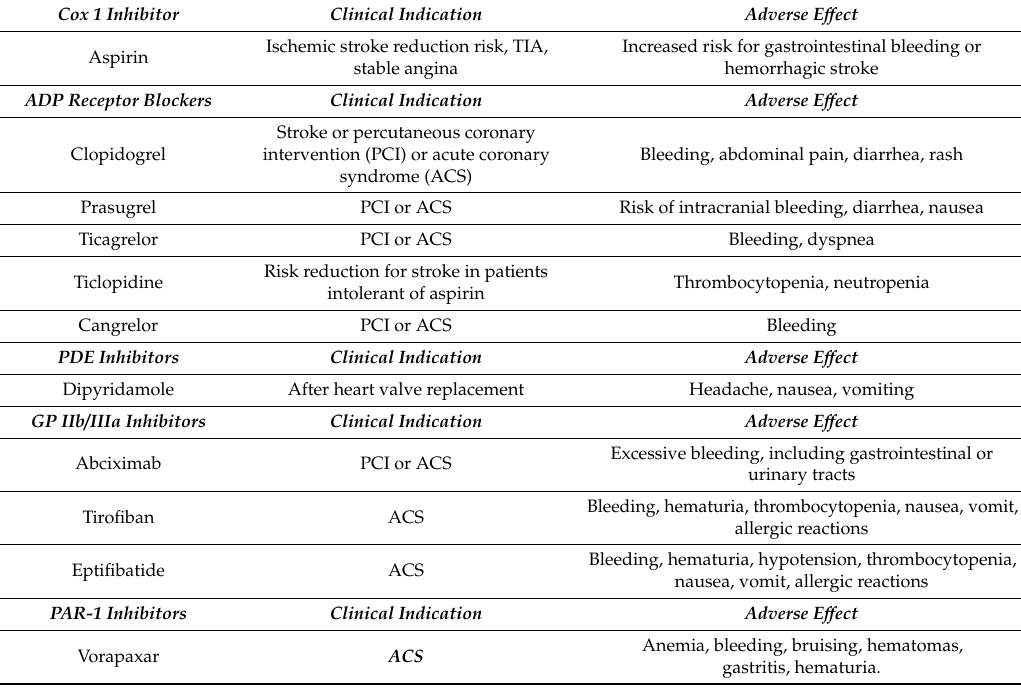
Table 1. Most common antiplatelet drugs with clinical indications and adverse e ff ects.